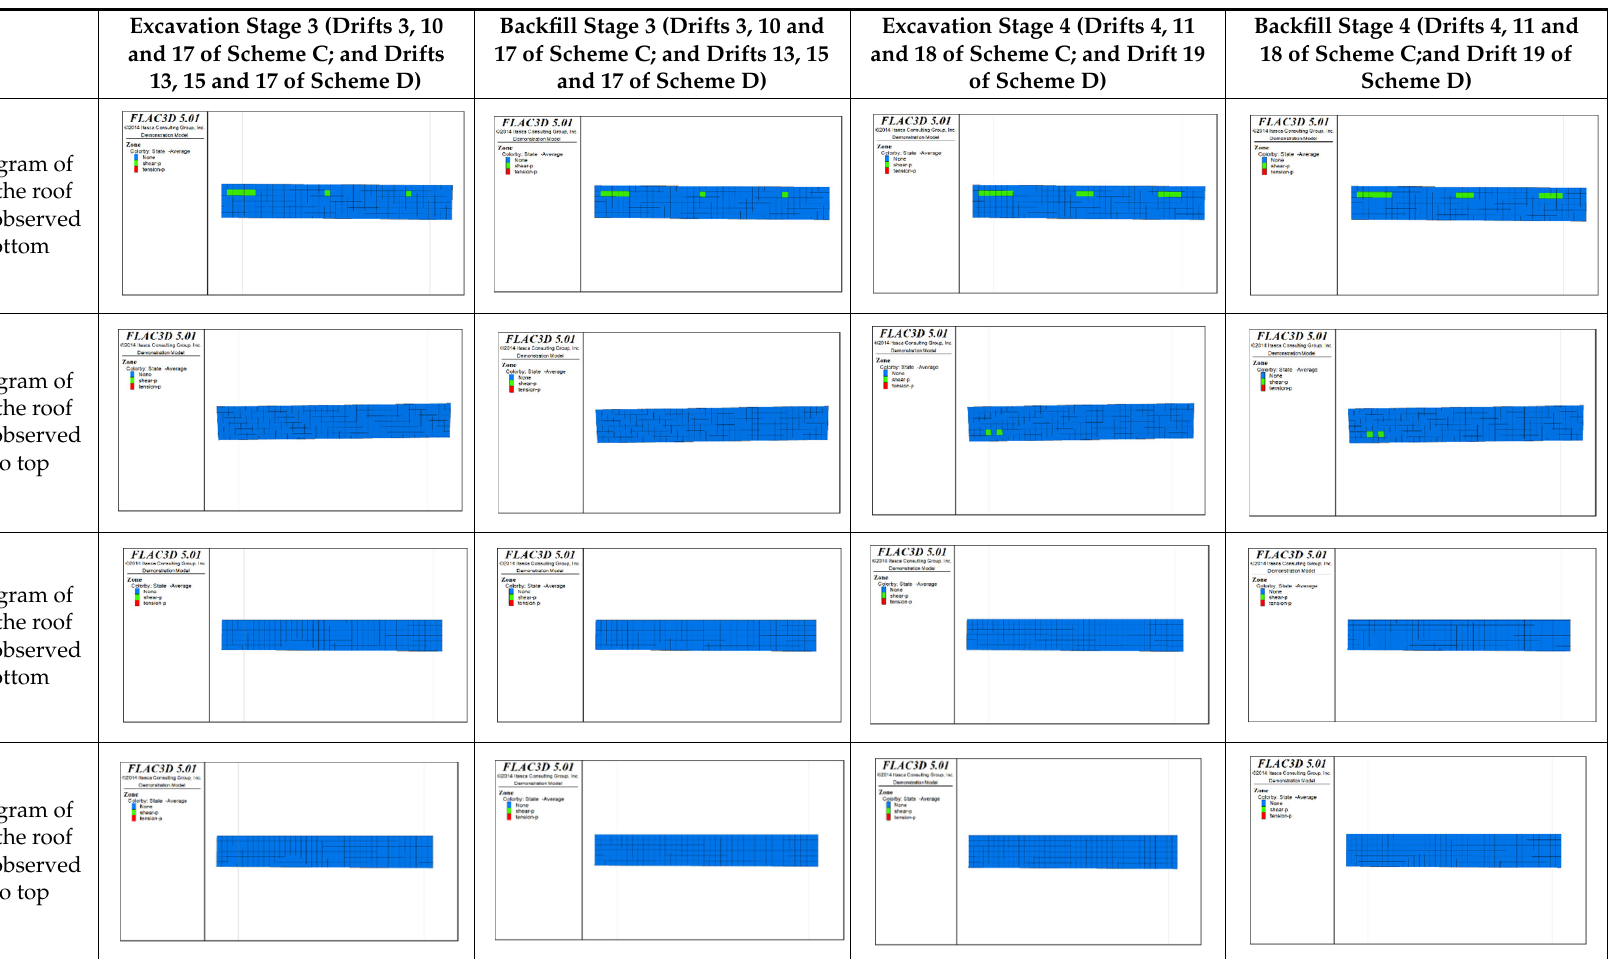
Table 7. Distributions of roof protection layer plastic zones under Schemes C and D (excavation stages 3 and 4).